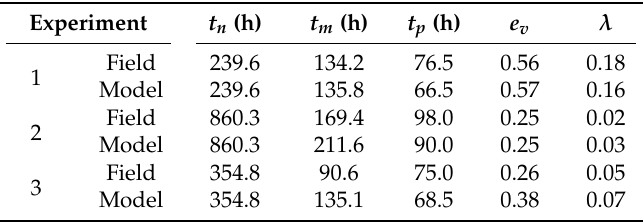
Table 1. Model validation by field measurements of hydraulic retention time, effective volume ratio, and hydraulic